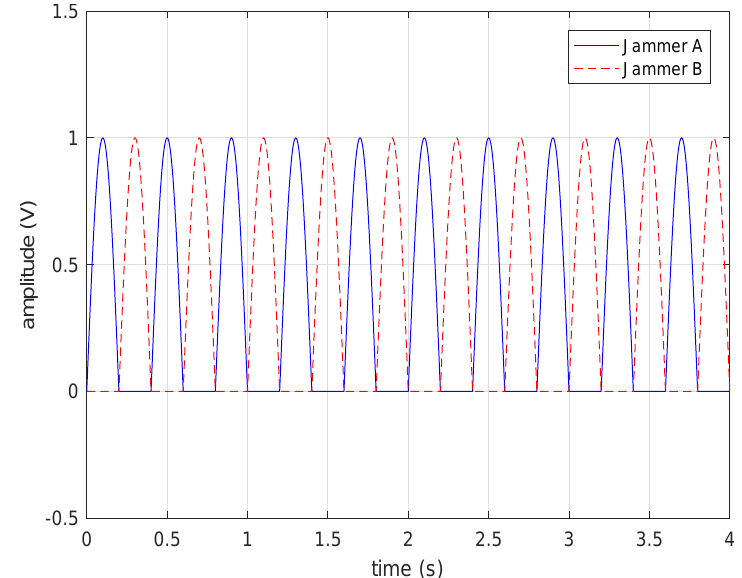
Figure 22. The jammer blink waveforms from sources A and B operating at a 4 Hz and 180 ◦ out of phase with a sinusoidal amplitude modulation